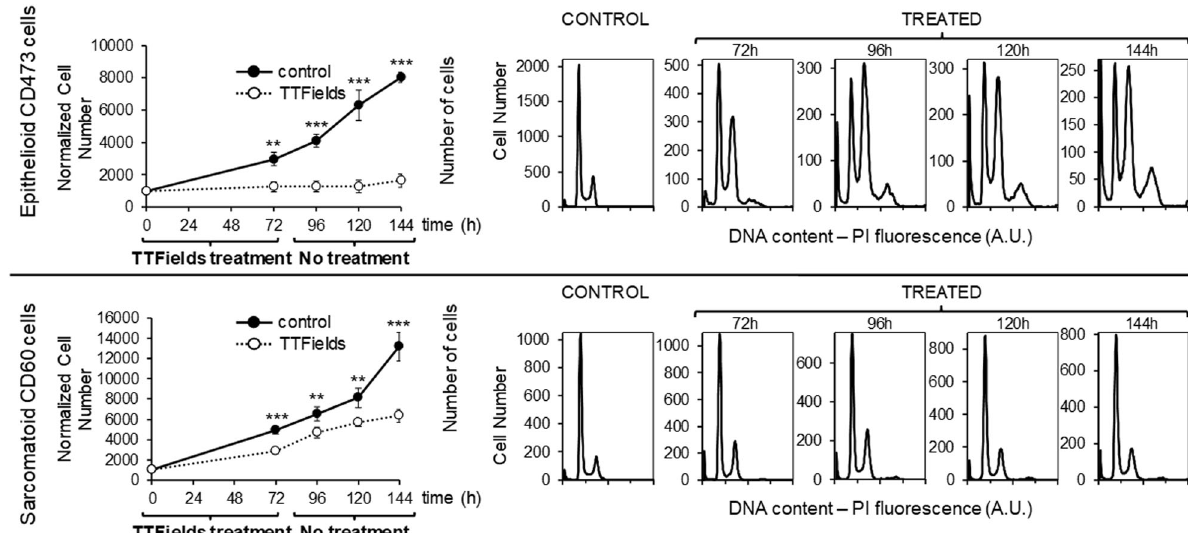
Fig. 4 Cell proliferation after TTFields discontinuation. Cell count and DNA histograms of epithelioid CD473 and sarcomatoid CD60 MPM cells exposed for 72 h to 1.12 V/cm TTFields or left untreated, and then let grow under control conditions for an additional 72 h. Statistical signi fi cance was analyzed by Student ’ s t test (** p < 0.01; *** p <